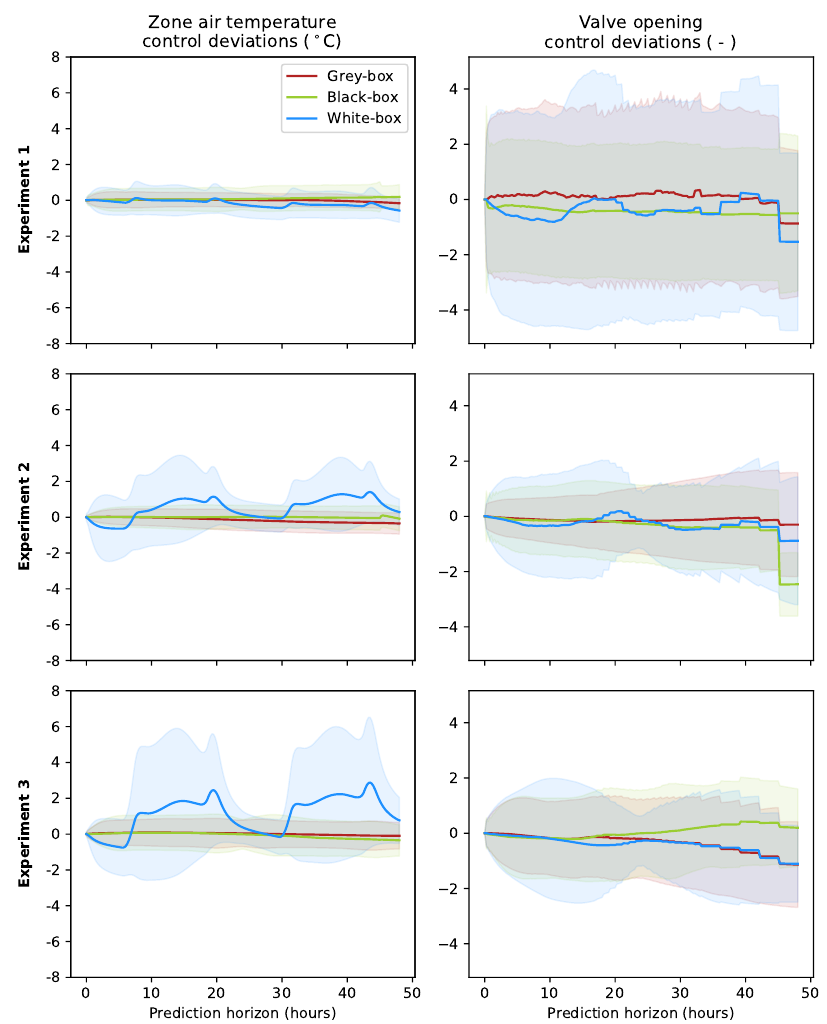
Figure 7. Mean and standard deviation of the control deviation as function of the prediction horizon. The graphs in the left column show the control deviations for the zone air temperature in each experiment and have units of ( ◦ C). The graphs in the right column show the control deviations for the valve opening in each experiment and have no units (-). Note that negative values are possible since both positive and negative control deviations can occur between predictions and observed